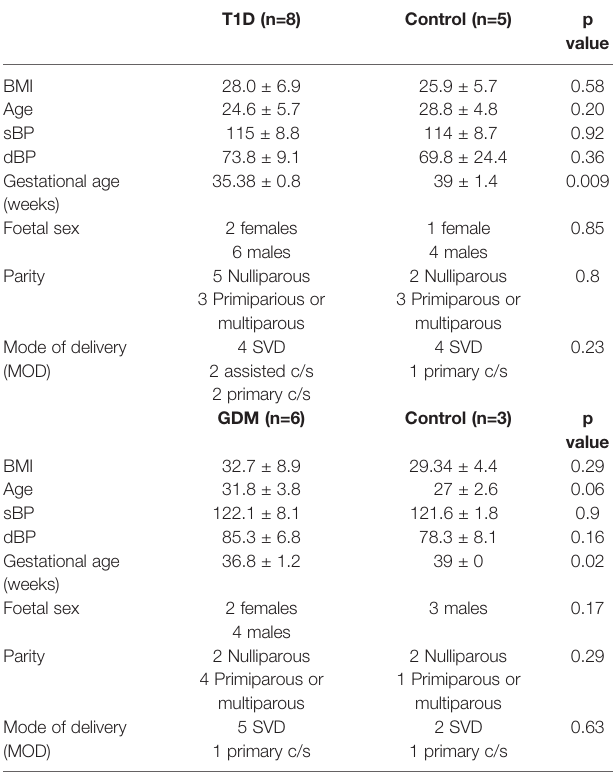
TABLE 1 | Maternal baseline characteristics for pregnant women with type 1 diabetes and gestational